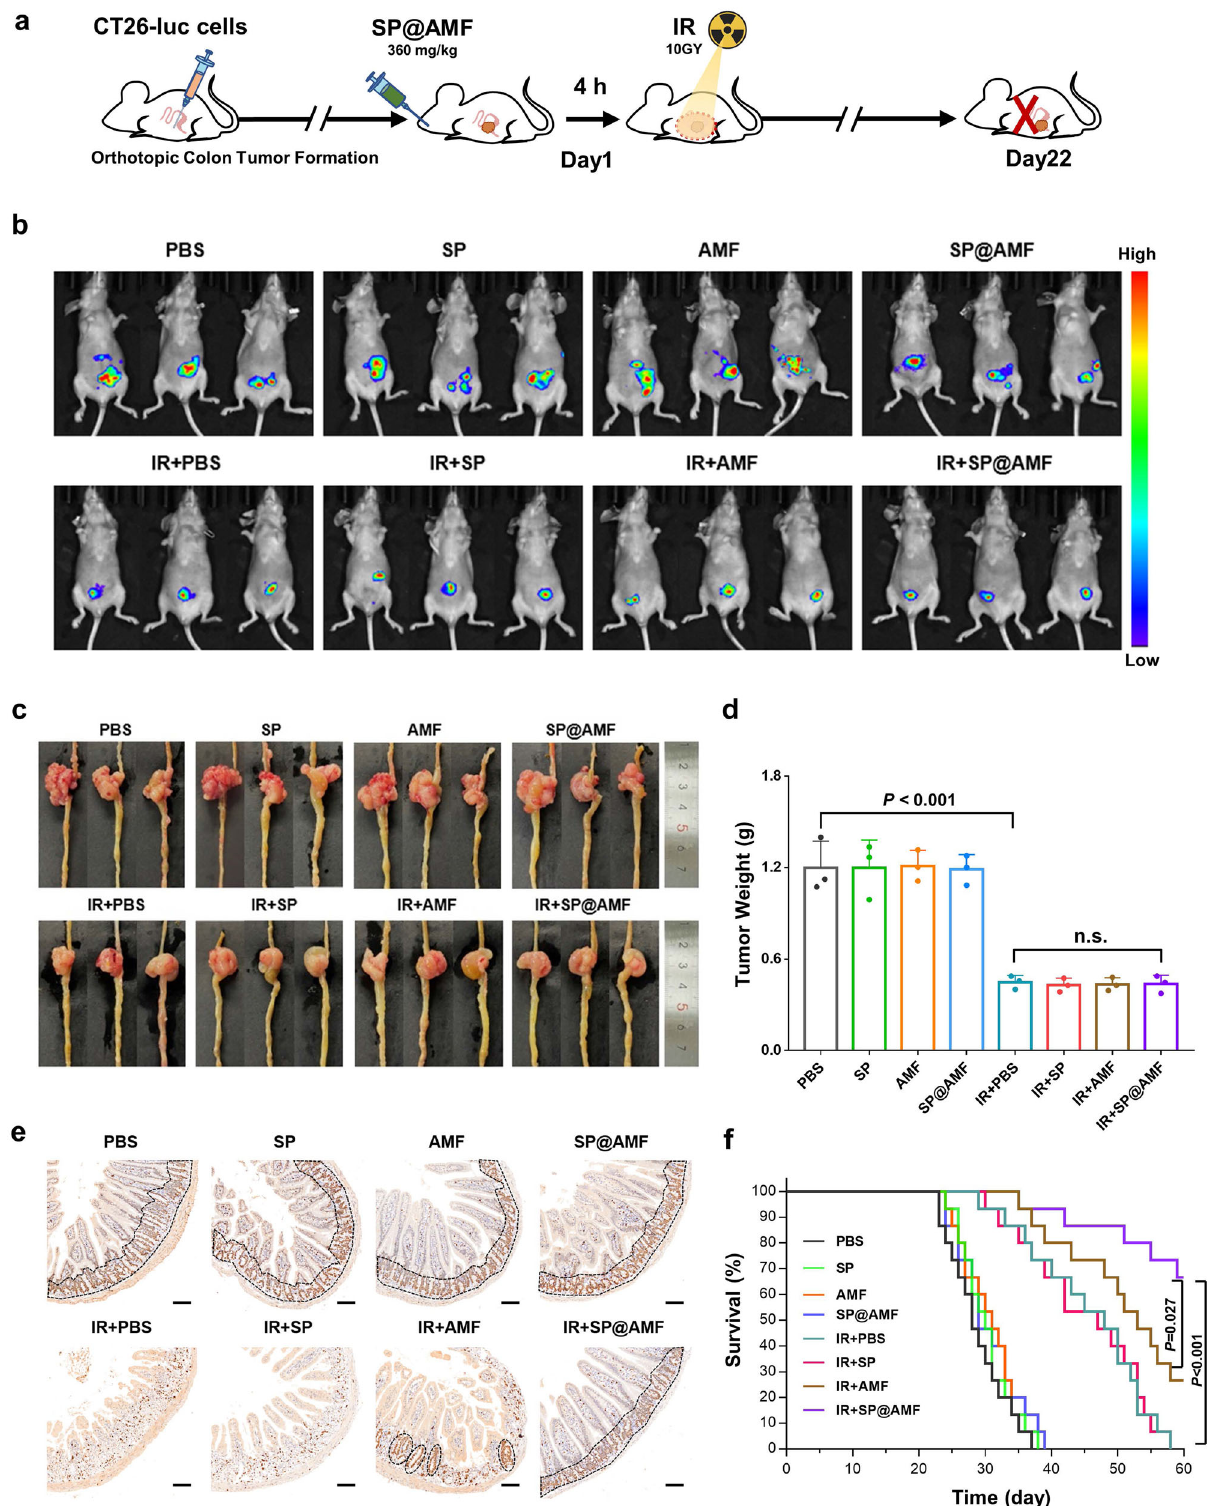
Fig. 7 SP@AMF does not in fl uence the regression of orthotopic colorectal tumor while protecting the normal intestine in radiotherapy. a Schematic illustration of the experiment protocol. b – d Fluorescence images ( b ), photographs ( c ), and weights ( d ) of the mice ’ s tumors at day 22 after being treated by sham irradiation + PBS (PBS group), 10 Gy abdominal X-ray (IR) + PBS, IR + Cap@AMF, and IR + SP@AMF ( n = 3 biologically independent animals). The data show means + SD. P was calculated using two-tailed t -test. e Represented IHC images of the small intestine stained by Ki67. The black dotted line indicates the Ki67-stained regenerating crypts. Scale bar = 100 µ m. Experiment was repeated three times independently with similar results. f Survival curves of mice ( n = 15 biologically independent animals). Median survival: PBS, 28 days; SP, 30 days; AMF, 31 days; SP@AMF, 29 days; IR + PBS, 48 days; IR + SP, 47 days; IR + AMF, 53 days; IR + SP@AMF, unde fi ned (>60 days). P was calculated using Log-rank (Mantel-Cox) test.